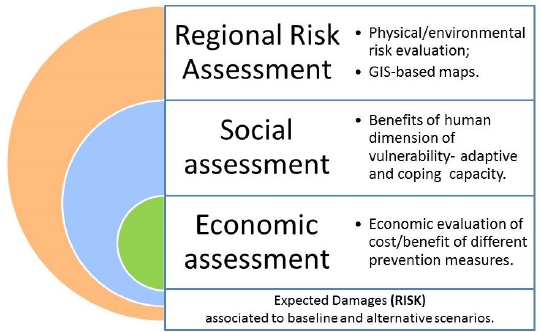
Figure 2. Tiers of analysis for the implementation of the (complete) KULTURisk